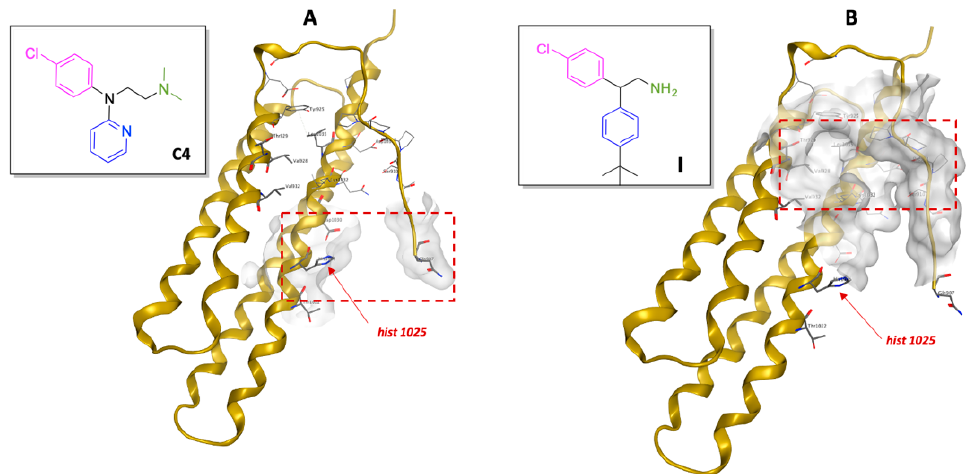
Figure 5. Comparison between the site selection (red dashed box) for the high throughout virtual screening of the drug-like FAK-FAT inhibitor; ( A ) previously identified chloropyramine ( C4 ) centred around His 1025. ( B ) Our virtual screening hit compound I centred around the Asp 1036, Ser 910, and Lys 1032 pocket.